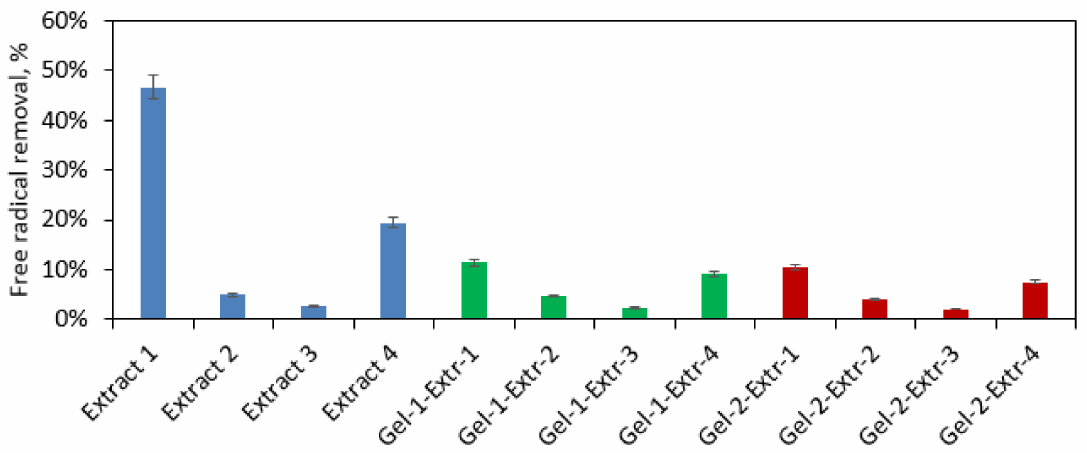
Figure 12. Antioxidant properties study by (2,2-diphenyl-1-picrylhydrazyl) (DPPH) method.